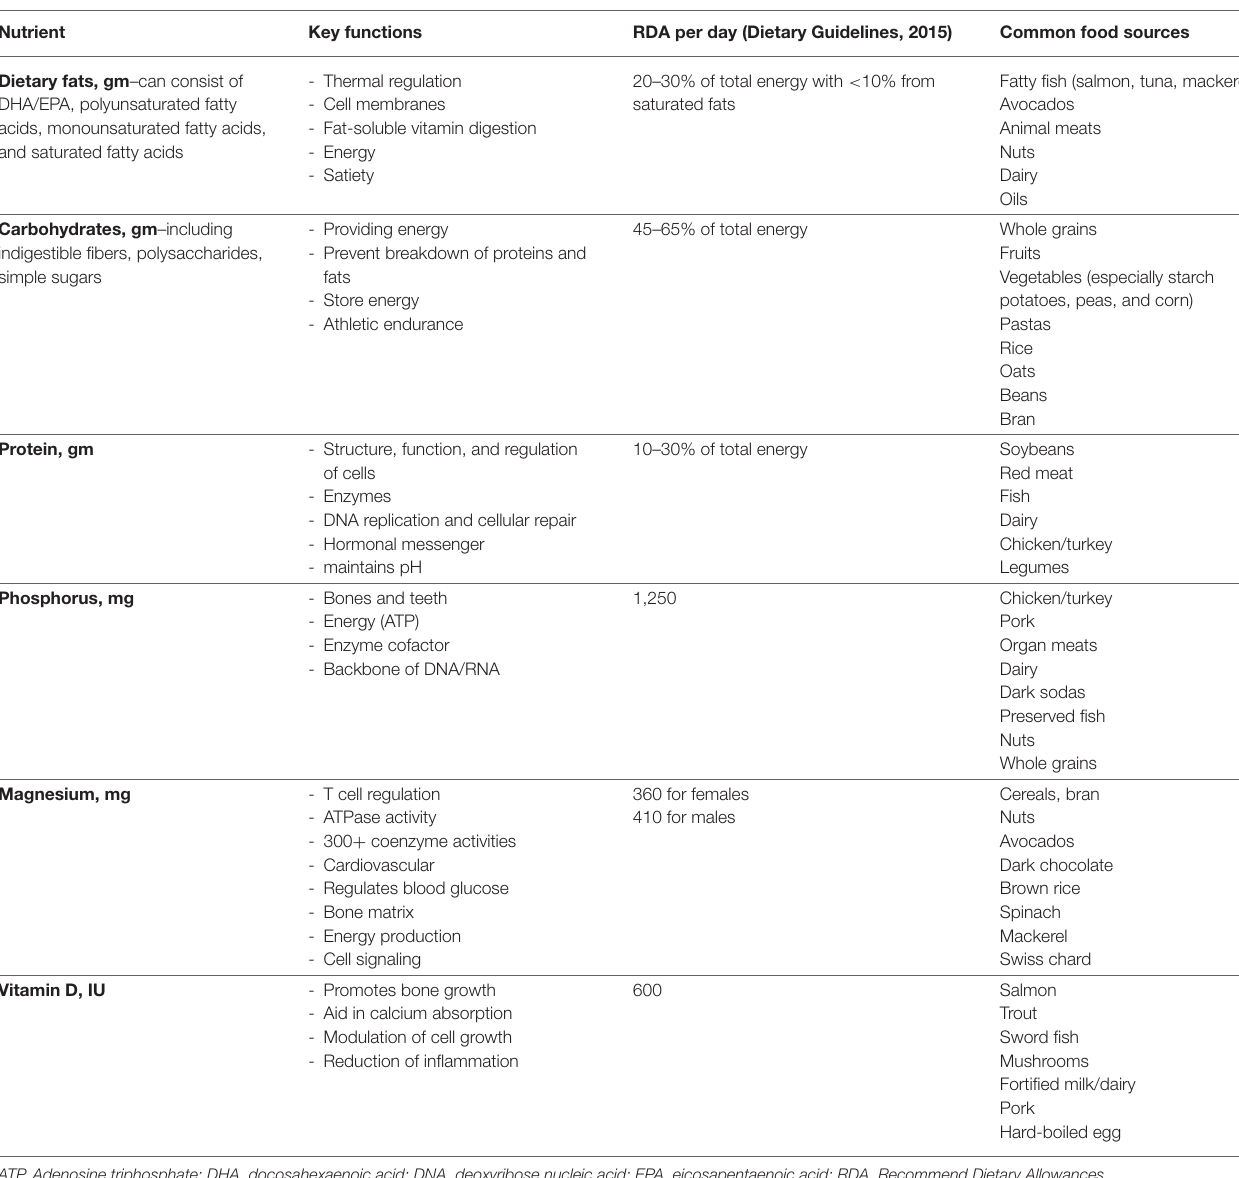
TABLE 1 | Key nutrients to consider for post-transplant kidney recipients based on recommendations for healthy adults. Nutrient Key functions RDA per day (Dietary Guidelines, 2015) Common food